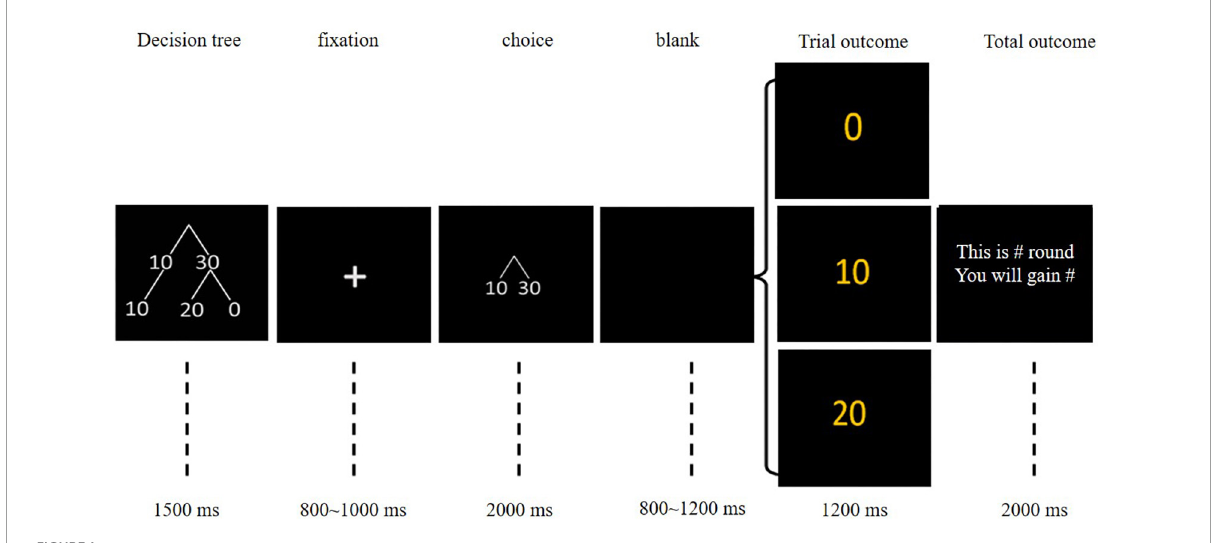
FIGURE1 Sequence of each trial in the trust